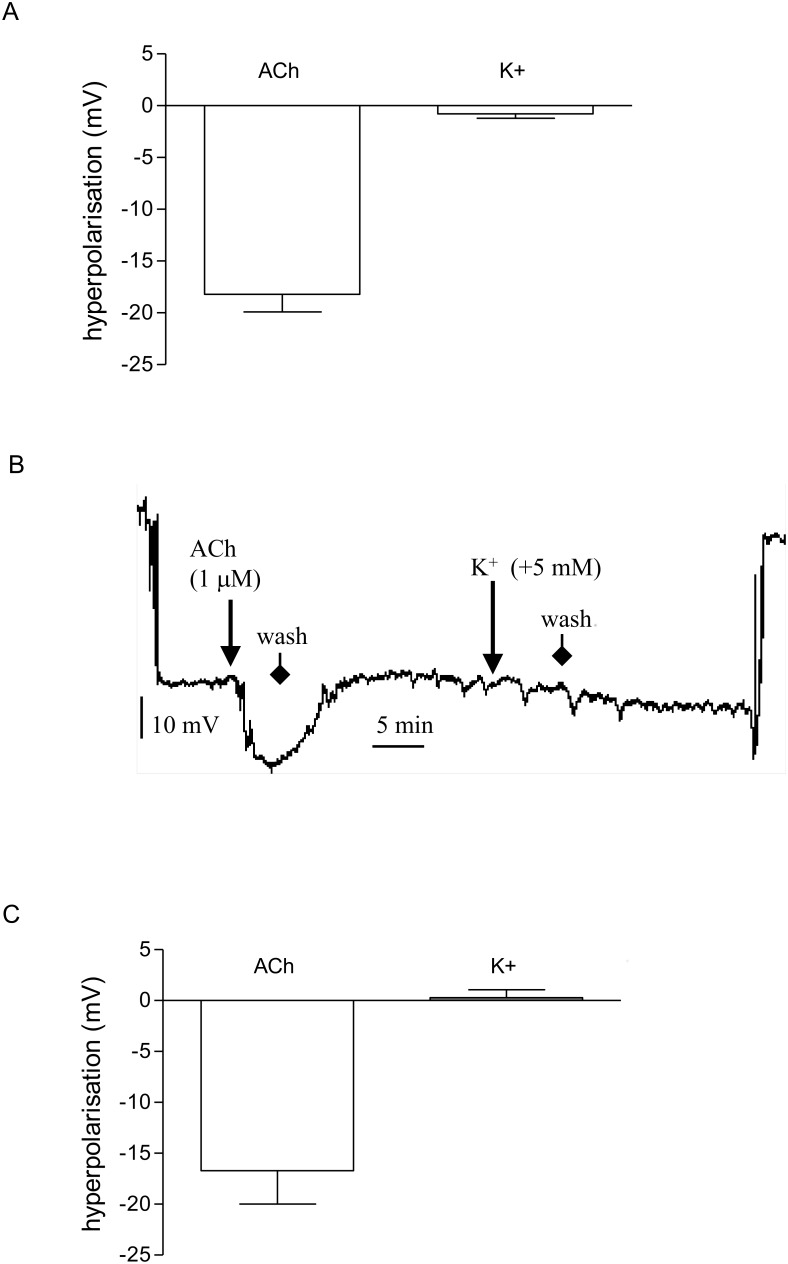
ACh causes hyperpolarization in pressurized small arteries, while raising extracellular potassium does not.Summary data showing the change in membrane potential in smooth muscle cells from n different animals in response to ACh (1 µM) and raised extracellular potassium (+5 mM) at (A) 30 mmHg and (C) 90 mmHg. Following the successful impalement of a cell, responses to ACh or potassium were recorded in random order. Bars represent mean ± s.e.mean (n = 3–6). Representative trace recording (B) of the change in membrane potential of a rat mesenteric small artery held at 30 mmHg and exposed to ACh (1 µM) followed by raised extracellular potassium (+5 mM). The large deflections at the start and end of the trace recording reflect cell impalement and removal of the microelectrode, respectively.